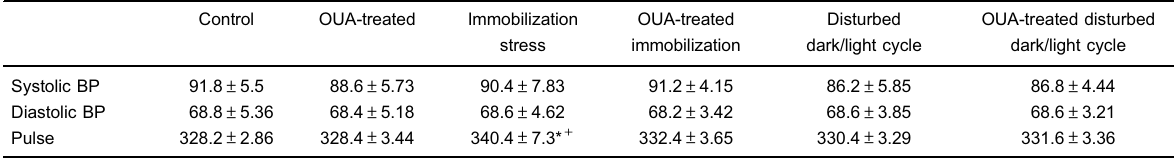
Data are reported as means ± SD for n=30 rats. *P o 0.002 compared to the control group; + P o 0.002 compared to ouabain (OUA)-